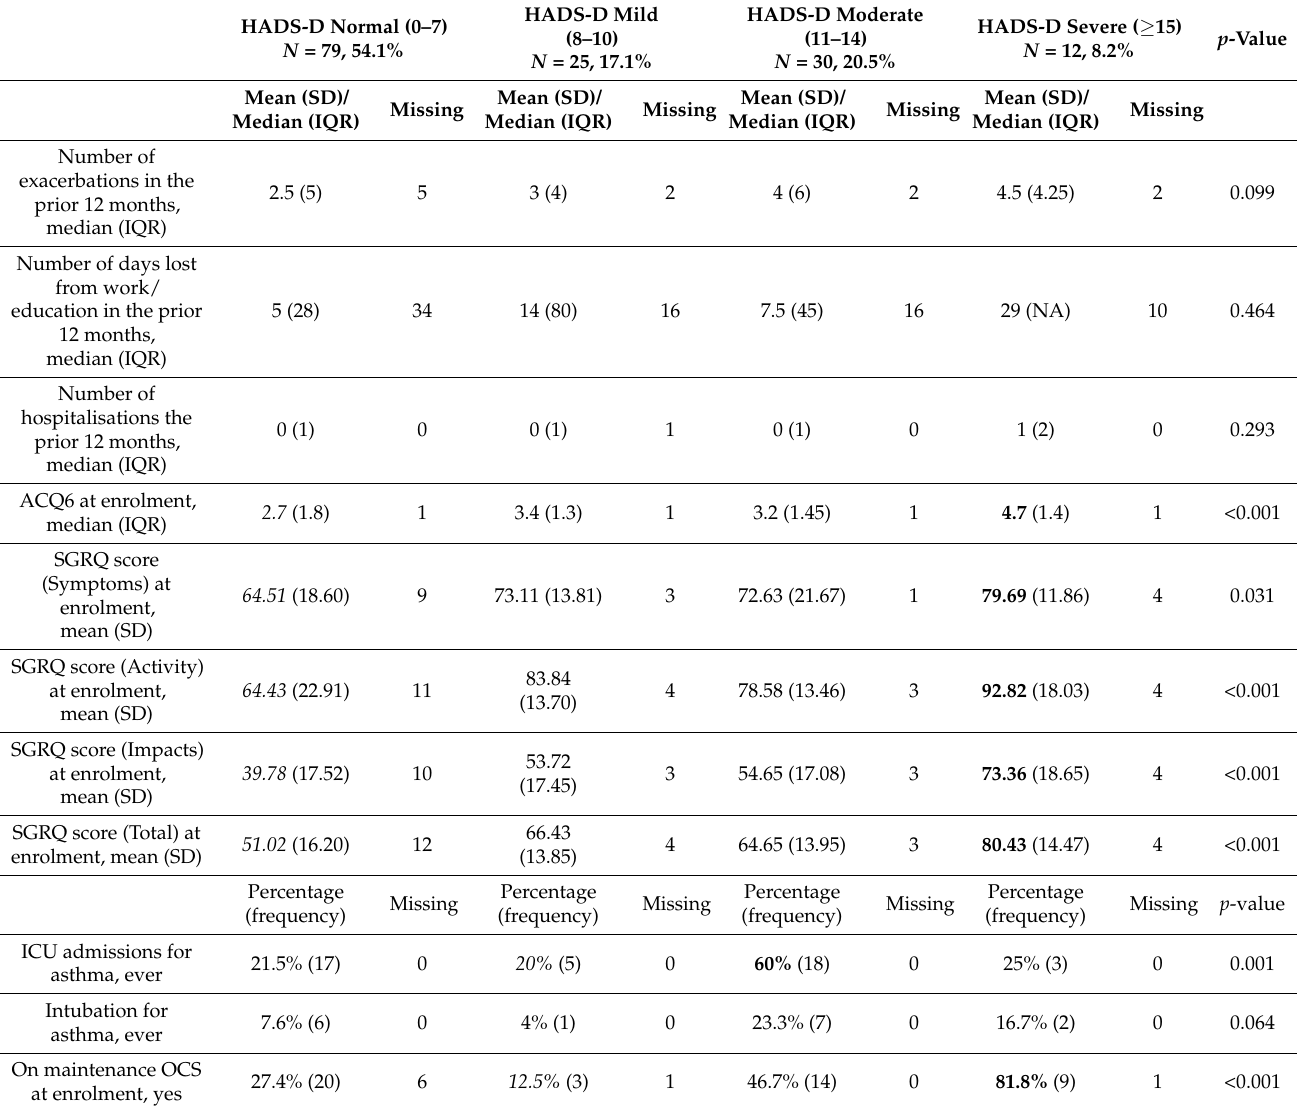
Table 5. Asthma outcomes of those with a clinical diagnosis of depression by HADS-D stratification.